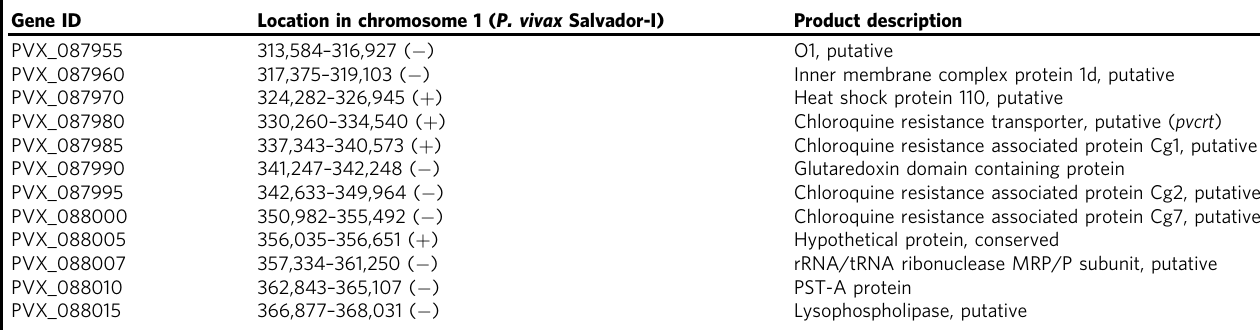
Table 1 P. vivax genes in the 76 kb region of chromosome 1 selected by chloroquine in mixed populations of NIH-1993 S × R progeny Gene ID Location in chromosome 1 ( P. vivax